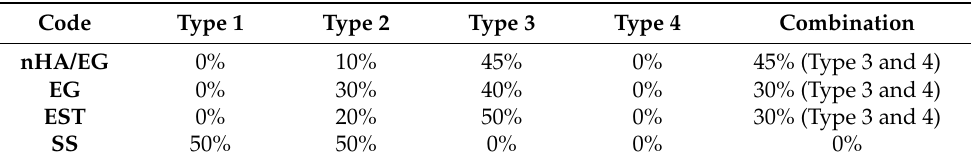
Table 2. Frequencies (%) of failure types of experimental and control orthodontic retainers after debonding.